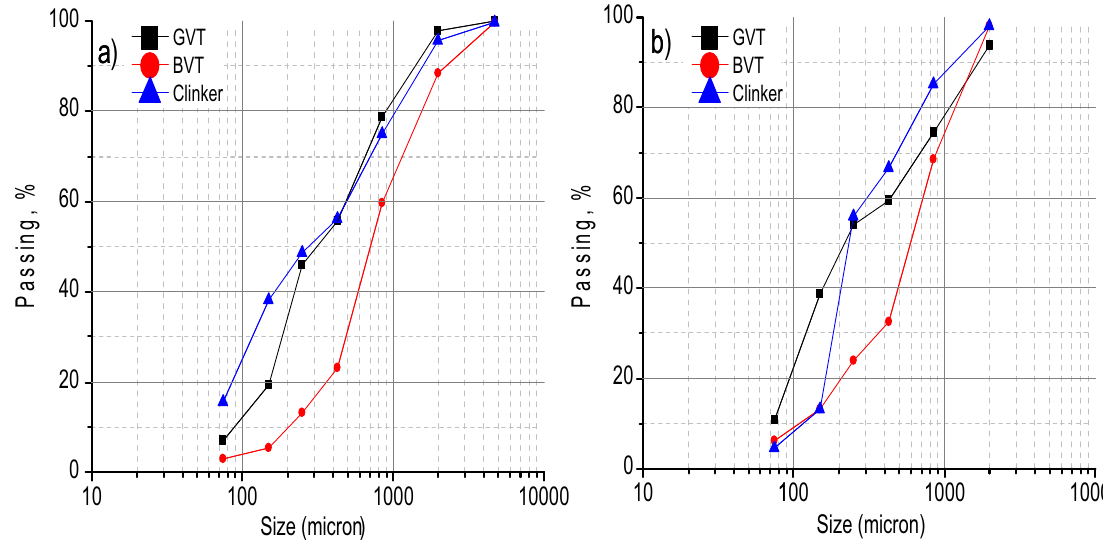
Figure 3: Particle size of the roller press ( a ) and the hammer crusher ( b )